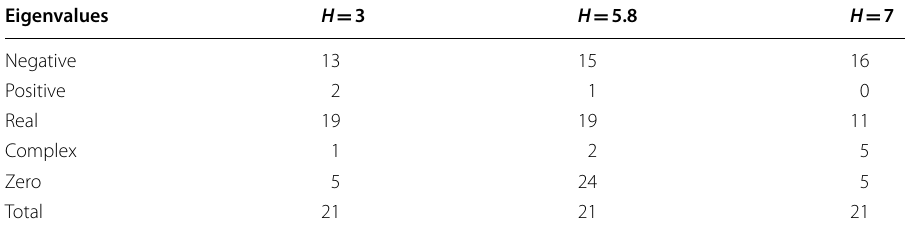
Table 8 Inertia affecting on system operation